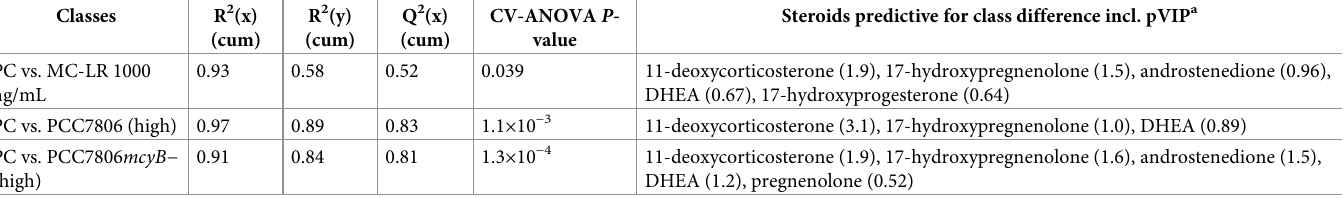
Subsequently, two-class OPLS discriminant analyses were performed, including the positive (1.5 μ M forskolin) control as one of the test groups, with the aim of identifying variables (i.e. steroids) with class-separating power. Three models were robust and met the quality criteria outlined above; these were from discriminant analysis of positive control vs. both of the high- concentration M . aeruginosa PCC7806 extracts (i.e. wild-type and mcyB− ) and from positive control vs. 1000 ng/mL MC-LR (Table 2). Significant models included between two and three components and interpreted at least 91% of the variation in X (i.e. the hormone levels). The predictive value of the three models was medium to high with cumulative Q 2 X values higher than 52% (Table 2). Hormones that were predictive for the observed class separation were extracted from the OPLS-DA S-plots (Fig 4) [63,64]. The strongest predictive hormone for class separations was 11-deoxycorticosterone (OPLS-DA predictive VIP = 1.9–3.1), which was upregulated in H295R cells following exposure both with 1000 ng/mL MC-LR and the high- Table 2. Characteristics of valid two-class OPLS-DA models based on quantitative hormone concentrations from 13 hormones following H295R cell exposures with either 1000 ng/mL MC-LR, M . aeruginosa PCC7806 or PCC7806 mcyB− extracts, compared to the positive control (1.5 μ M forskolin).